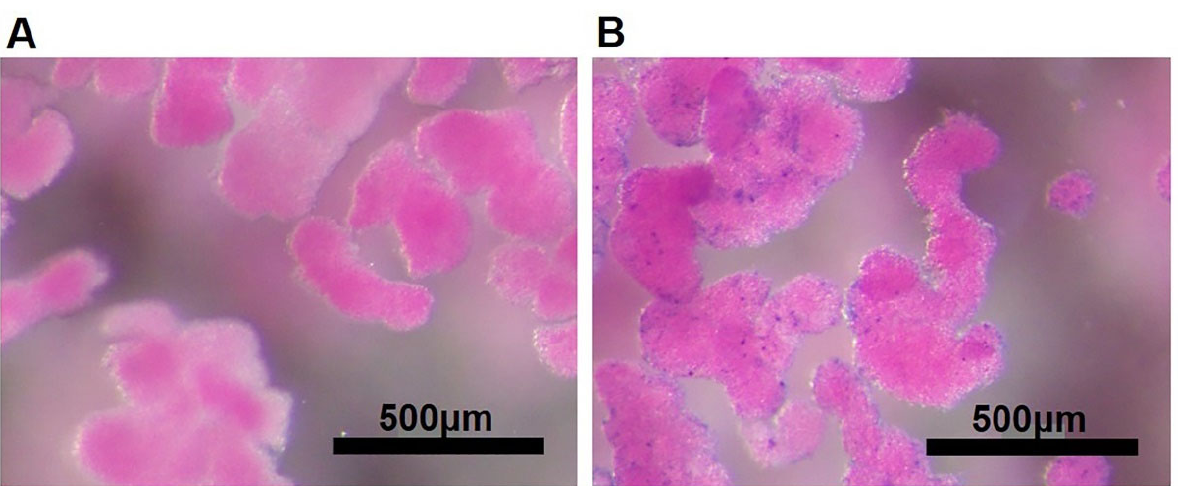
Figure 2. Binding of MnMEIO-Ex4 NPs to NPCCs. NPCCs were incubated overnight without ( A ) or with ( B ) MnMEIO-Ex4 NPs. The iron stained by Prussian blue expressed blue color only on the cell surface of NPCCs with MnMEIO-Ex4 NPs